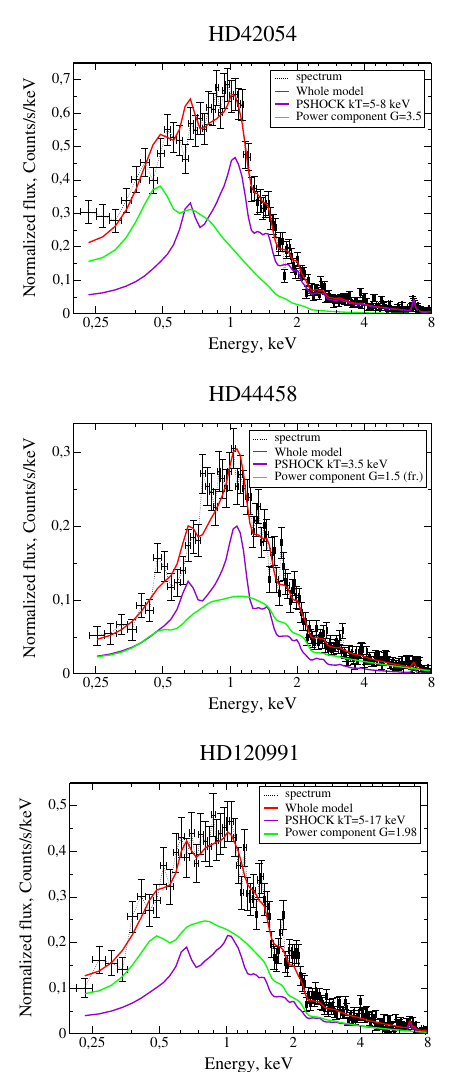
Figure 5. The same as in Figure 1 but for PSHOCK+PL models.